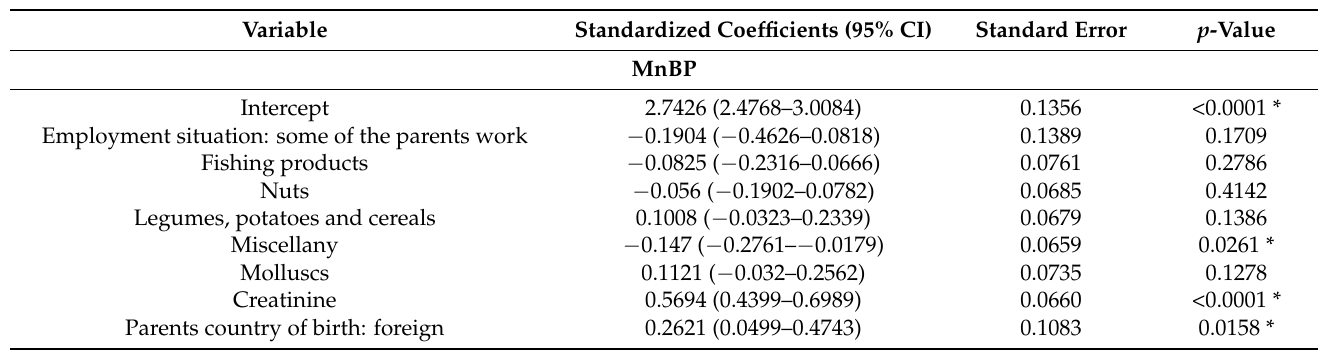
Table 4. Results of the robust multiple linear regression model for the logarithmically adjusted levels of phthalate metabo-